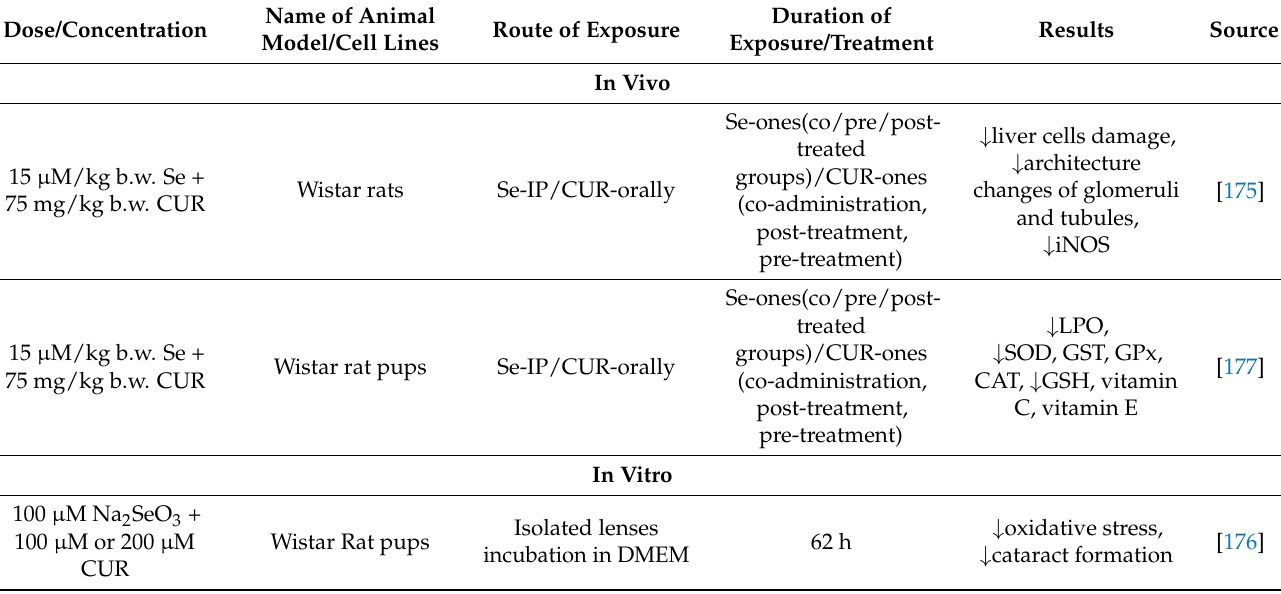
Table 10. Effects of curcumin on selenium toxicity based on doses, experimental methods, and